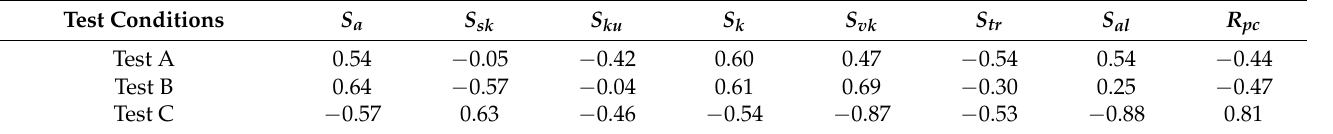
Table 5. Correlation coefficient between test frictions and the selected surface characteristics parameters.